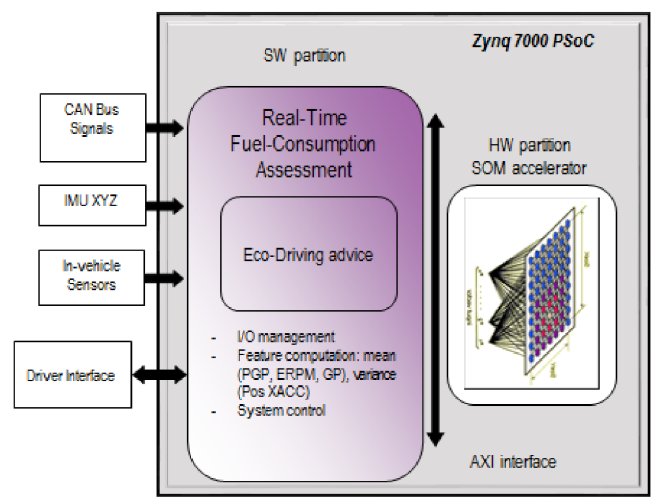
Figure 13. Block diagram of the programmable system-on-a-chip (PSoC) for real-time fuel consumption assessment and